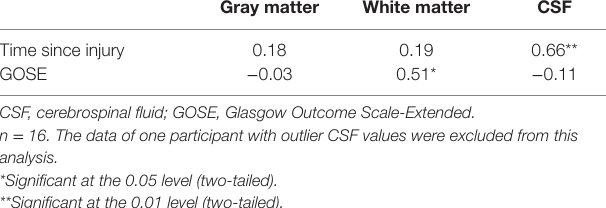
TaBle 4 | Pearson product-moment correlations of brain volume with neurocognitive measures. neurocognitive measure gray matter White matter csF Verbal memory CSF, cerebrospinal fluid. n = 32.